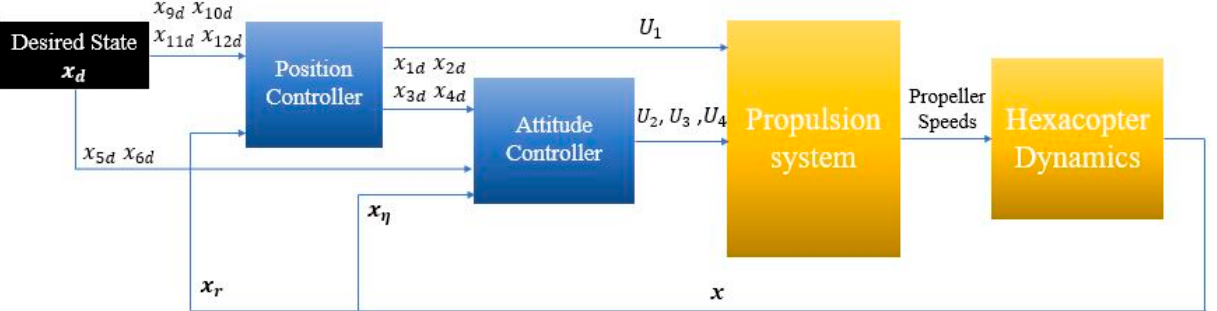
Figure 3. Control